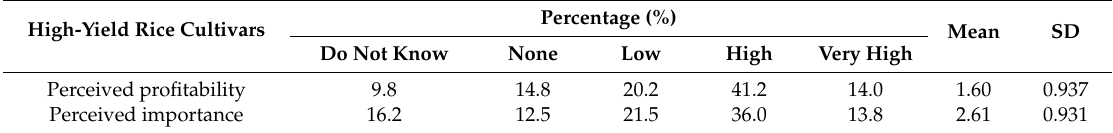
Table 5. Perceived profitability and perceived importance of improved cultivars among rice growers of Rudsar County ( n = 400).